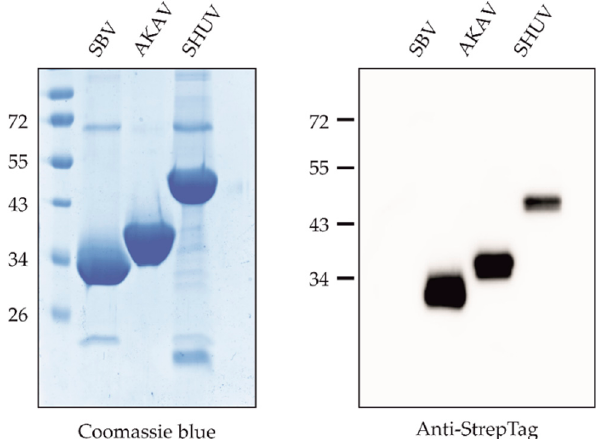
Figure 1. SDS-PAGE and Western blot analyses of recombinant proteins used for plate coating. The recombinant proteins were separated by reducing SDS-PAGE and analyzed by Coomassie staining (left panel) or Western blot (right panel) using an anti-StrepTag specific monoclonal antibody. Full-length blots are presented in the Appendix A (Figure A1).